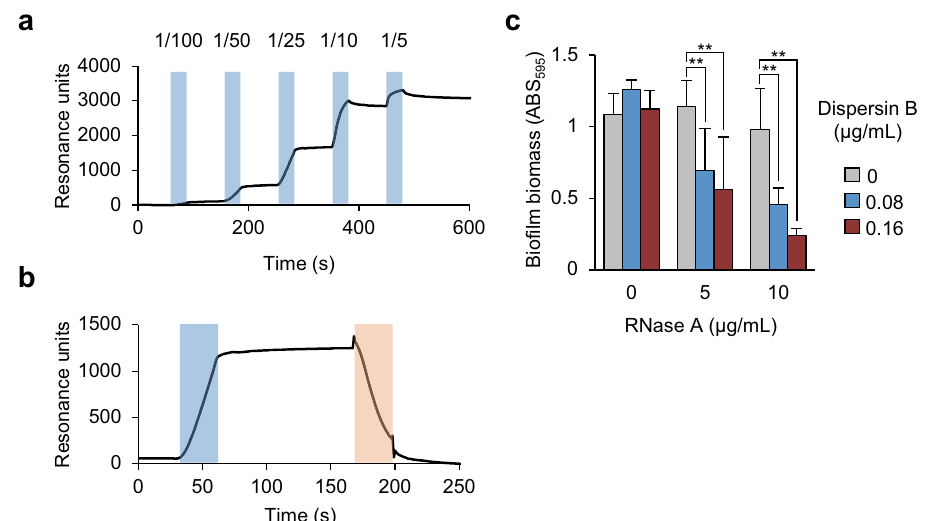
Fig. 6 Direct interaction between RNA and polysaccharides. a , b Interaction analysis between RNA and puri fi ed polysaccharides was performed using surface plasmon resonance. The biotinylated 19 R was immobilized on a streptavidin-coated sensor chip. a Puri fi ed polysaccharides were diluted to the indicated folds and were applied to the fl ow cell during the time points (second) denoted in light blue. b Puri fi ed polysaccharides were diluted to 25-fold and were applied to the fl ow cell during the times denoted in light blue. Subsequently, diluted dispersin B (16 µg/mL) was applied during the times denoted in orange. c The 24-h MR10 bio fi lms were treated with the indicated concentrations of RNase A and/or dispersin B for 60 min at 37 °C. To avoid the destruction of the preformed bio fi lms, low concentrations of RNase A and dispersin B alone were used. The data are presented as the mean and standard deviation (error bar) of three independent experiments. ** P <